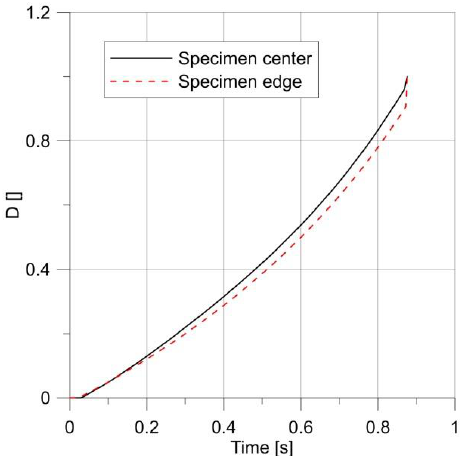
Figure 13. The distribution of effective stress ( a ) and the parameter D ( b ) just before the moment of failure of the sample, with the notch R = 2.5 mm.